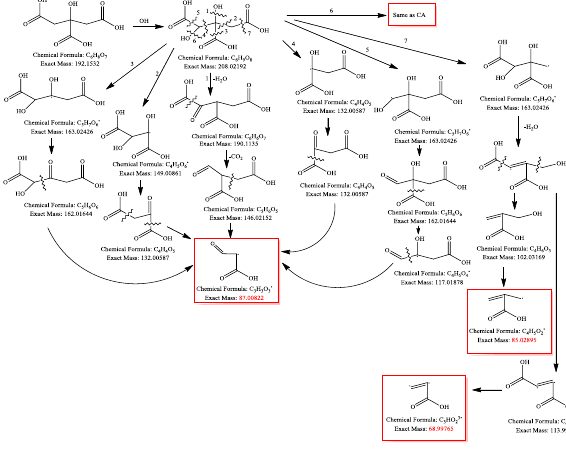
Scheme 2. Possible fragmentation pathways for an oxidation prod- uct of citric acid in terms of the general chemistry described by Atkinson